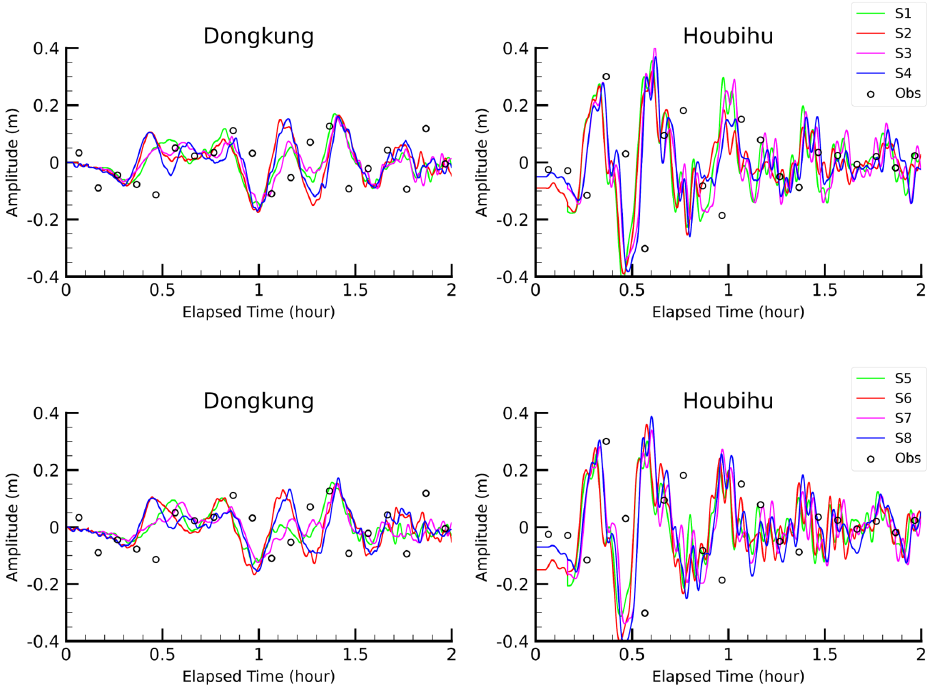
Figure 17. Comparison of simulated tsunami waveforms at the Dongkung and Houbihu stations using single fault models with eight different models of focal mechanisms estimated by GCMT and USGS.